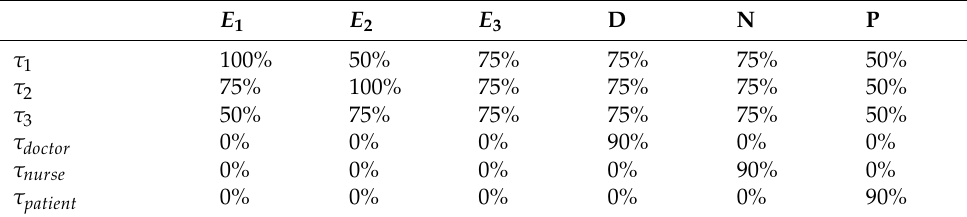
Table 2. Average performance of the category members for each